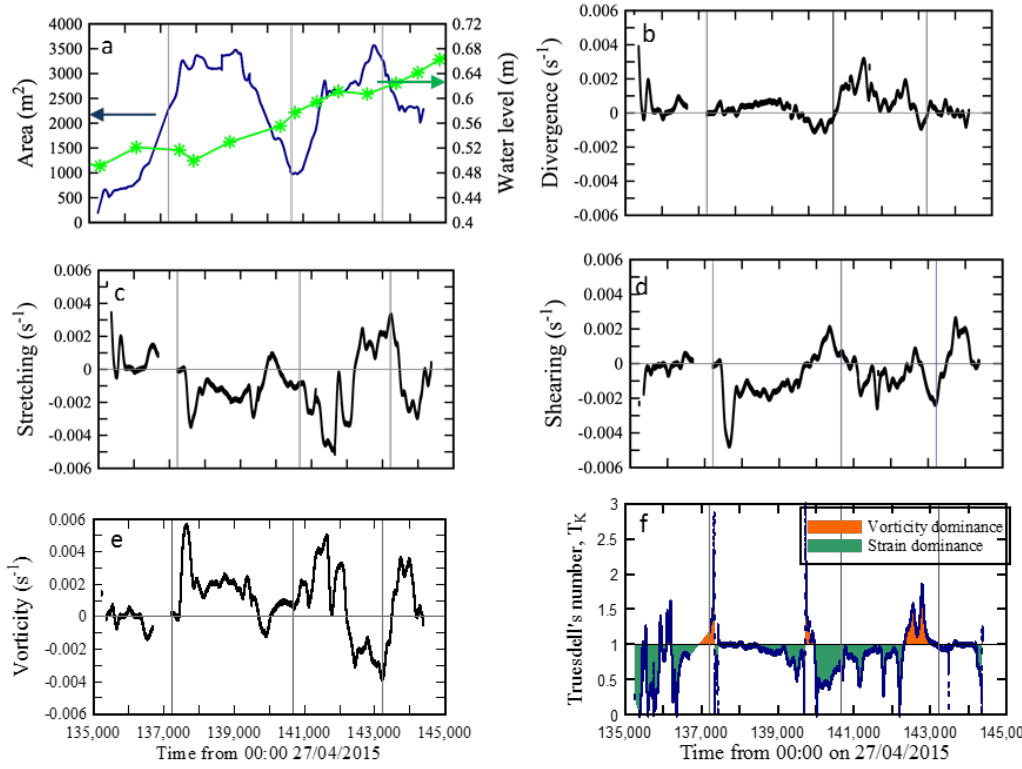
Figure 9. Time variations of cluster properties during open state (E1) Flood experiment: ( a ) Area and water level (m) in channel (* green line), ( b – e ) differential kinematic properties (Equation (6)), ( b ) Divergence, ( c ) Stretching, ( d ) Shearing, ( e ) Vorticity, ( f ) Time variation of Truesdell’s kinematic (blue line) vorticity number (Equation (7)). Note: the number of active drifters 5–15; periods with drifter numbers, n < 5 are not included.